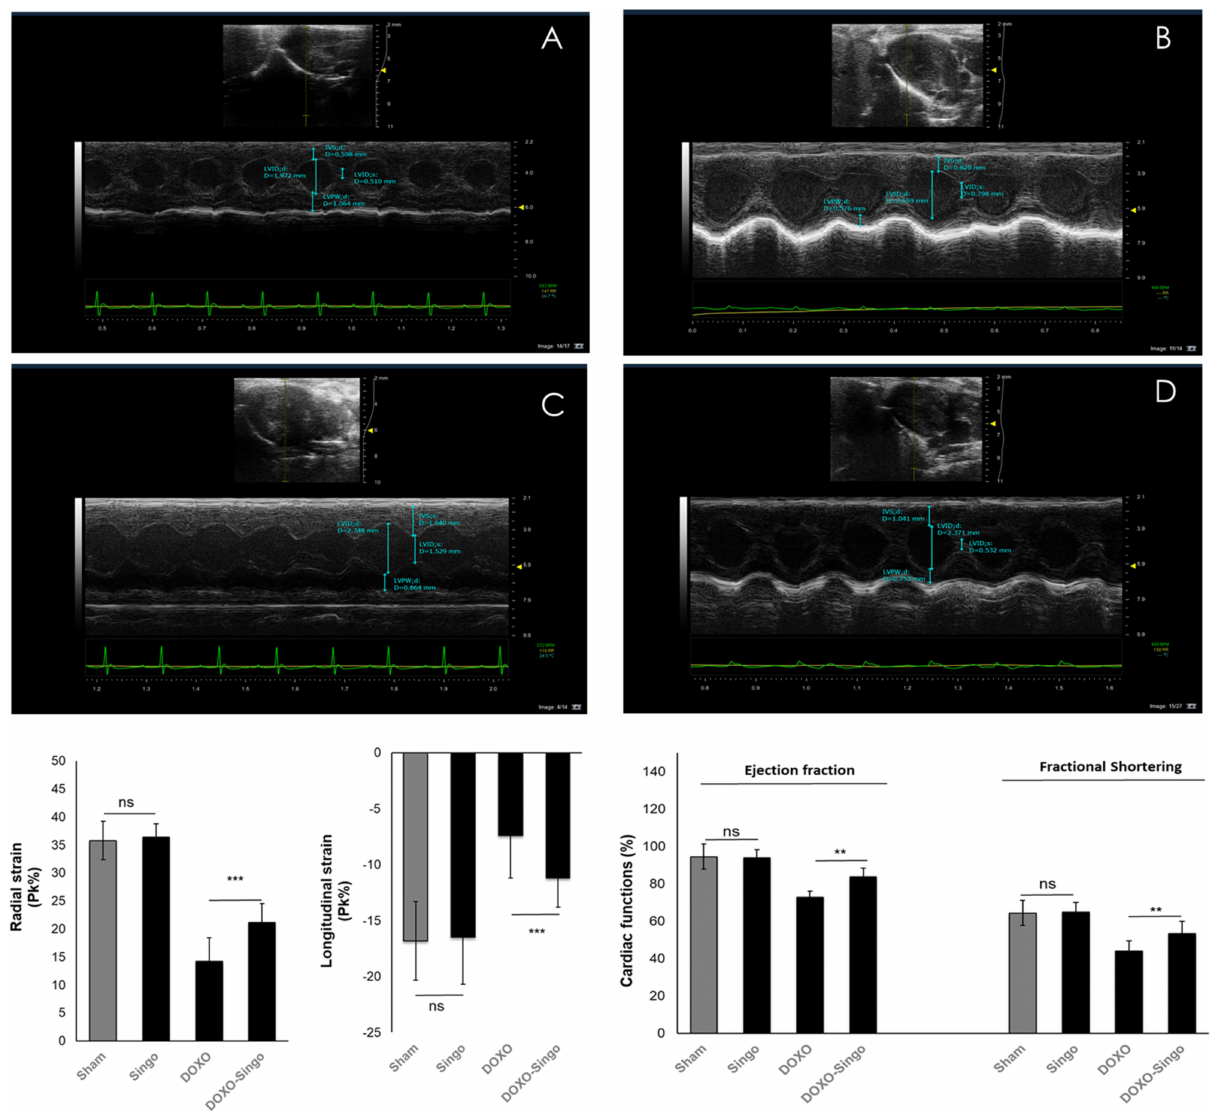
Figure 4. Cardiac function studies in mice untreated (saline) or treated with Singo at 12 mg/kg/day, Doxorubicin (DOXO) at 1.25 mg/kg/day and both in combination for 10 days. Vevo 20,100 model was used as echocardiography for the determination of radial strain, longitudinal strain, ejection fraction and fractional shortening. Up: A characteristic picture of cardiac contractility in mice untreated ( A ), treated with Singo ( B ) or DOXO ( C ) or both in combination ( D ). Down: Radial strain (Pk %), Longitudinal Strain (Pk %), Ejection Fraction (%) and Fractional Shortering (%) in mice untreated or treated with Singo or DOXO or both in combination. Results: mean +/ − SD. ns: not significant; *** p < 0.001. ** p <